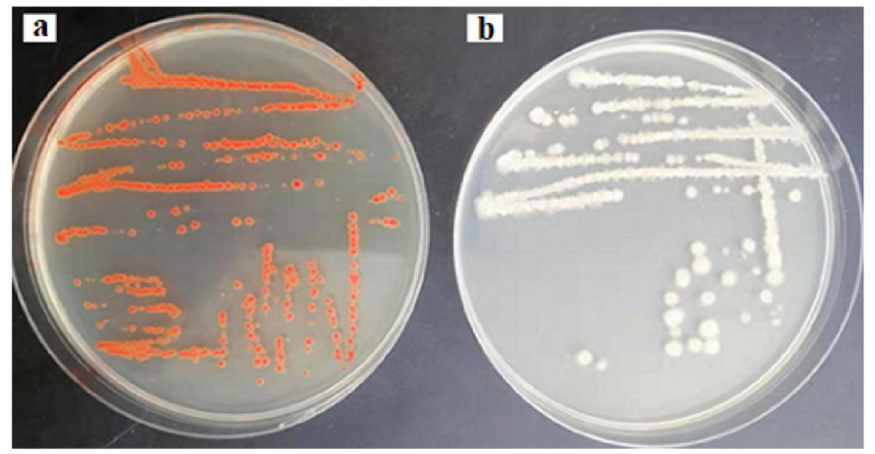
Figure 1. Reddish colonies of BSN313 in the presence of 6 µ g/mL Se in Luria Broth (LB) ( a ) and control ( b ).